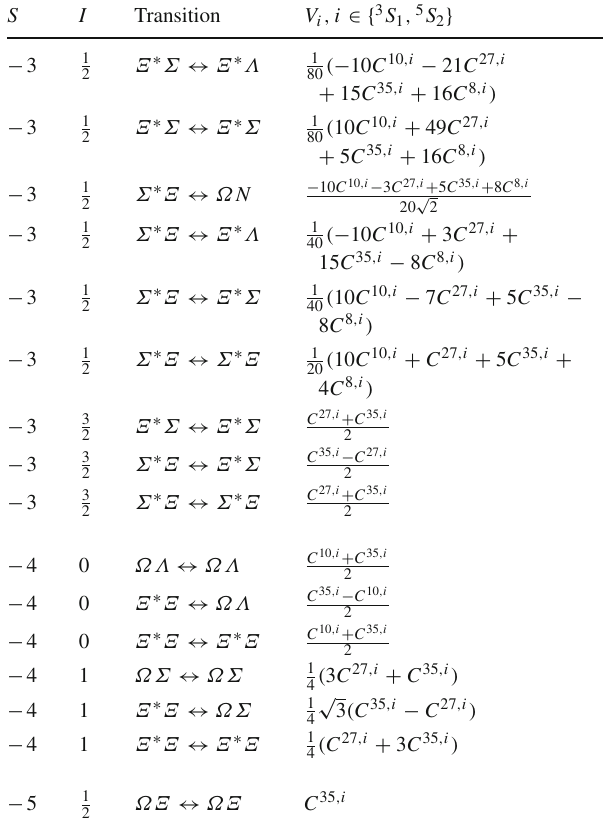
Table 10 SU(3) relations of DB → DD (and DD → DB) in non- vanishing partial waves. The subscript { 12 } of the constants C r denotes the BB channel is omitted in the